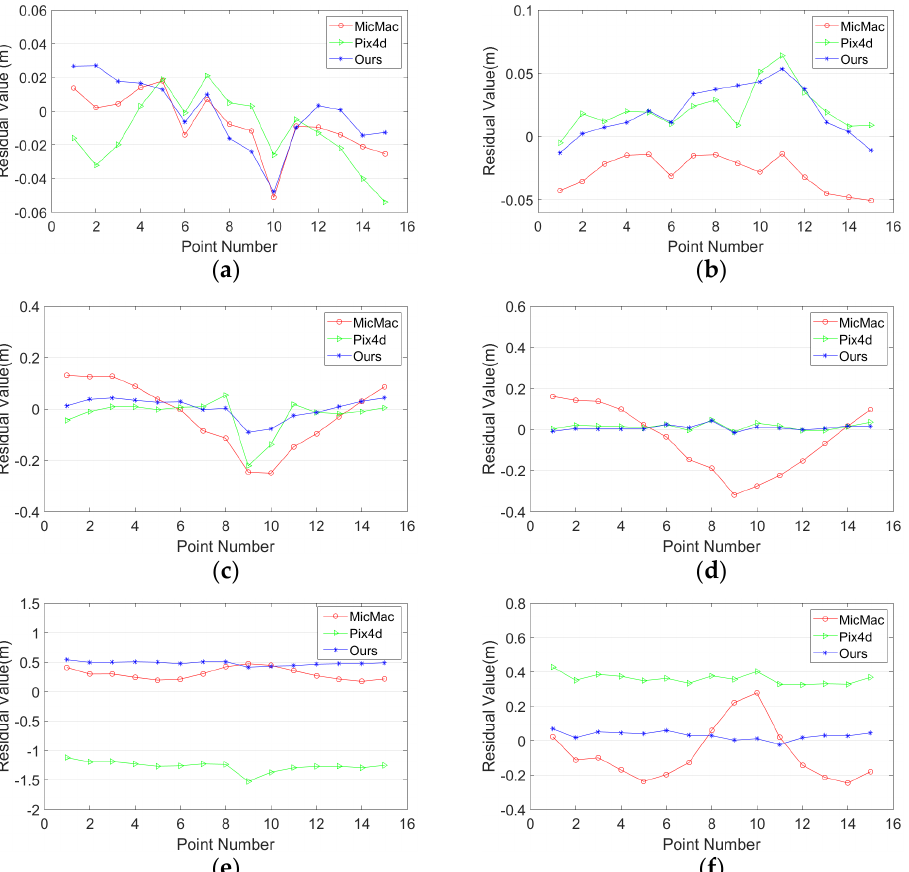
Figure 10. The residuals of check points after self-calibration with different software for test site 1.